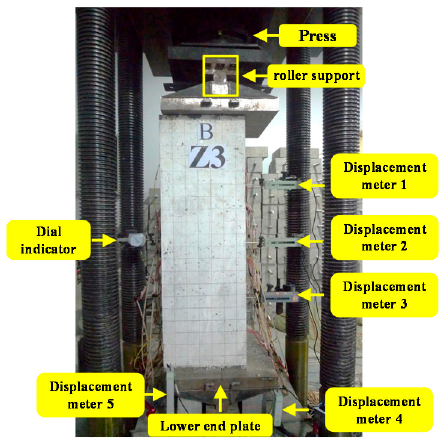
Figure 4. Test site conditions.